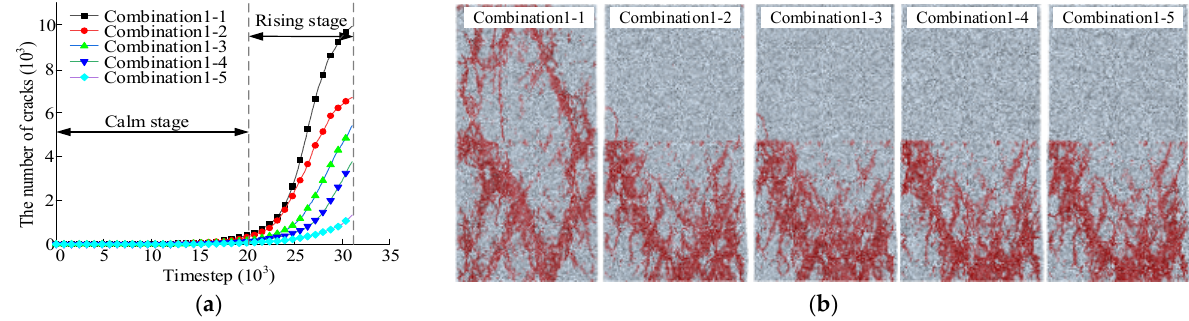
Figure 5. Failure characteristics of coal–rock combinations. ( a ) The number of cracks in combination with timestep. ( b ) Failure pattern of combinations.